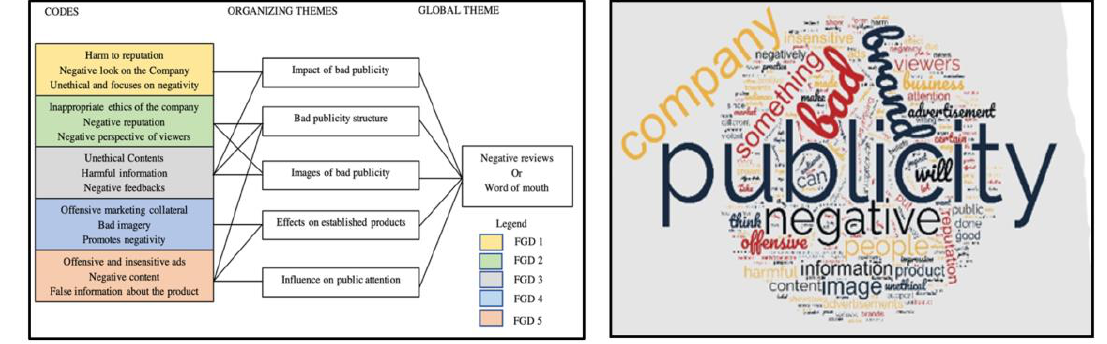
Figure 5: Concept Map of Bad Publicity Figure 6: Definition of Bad